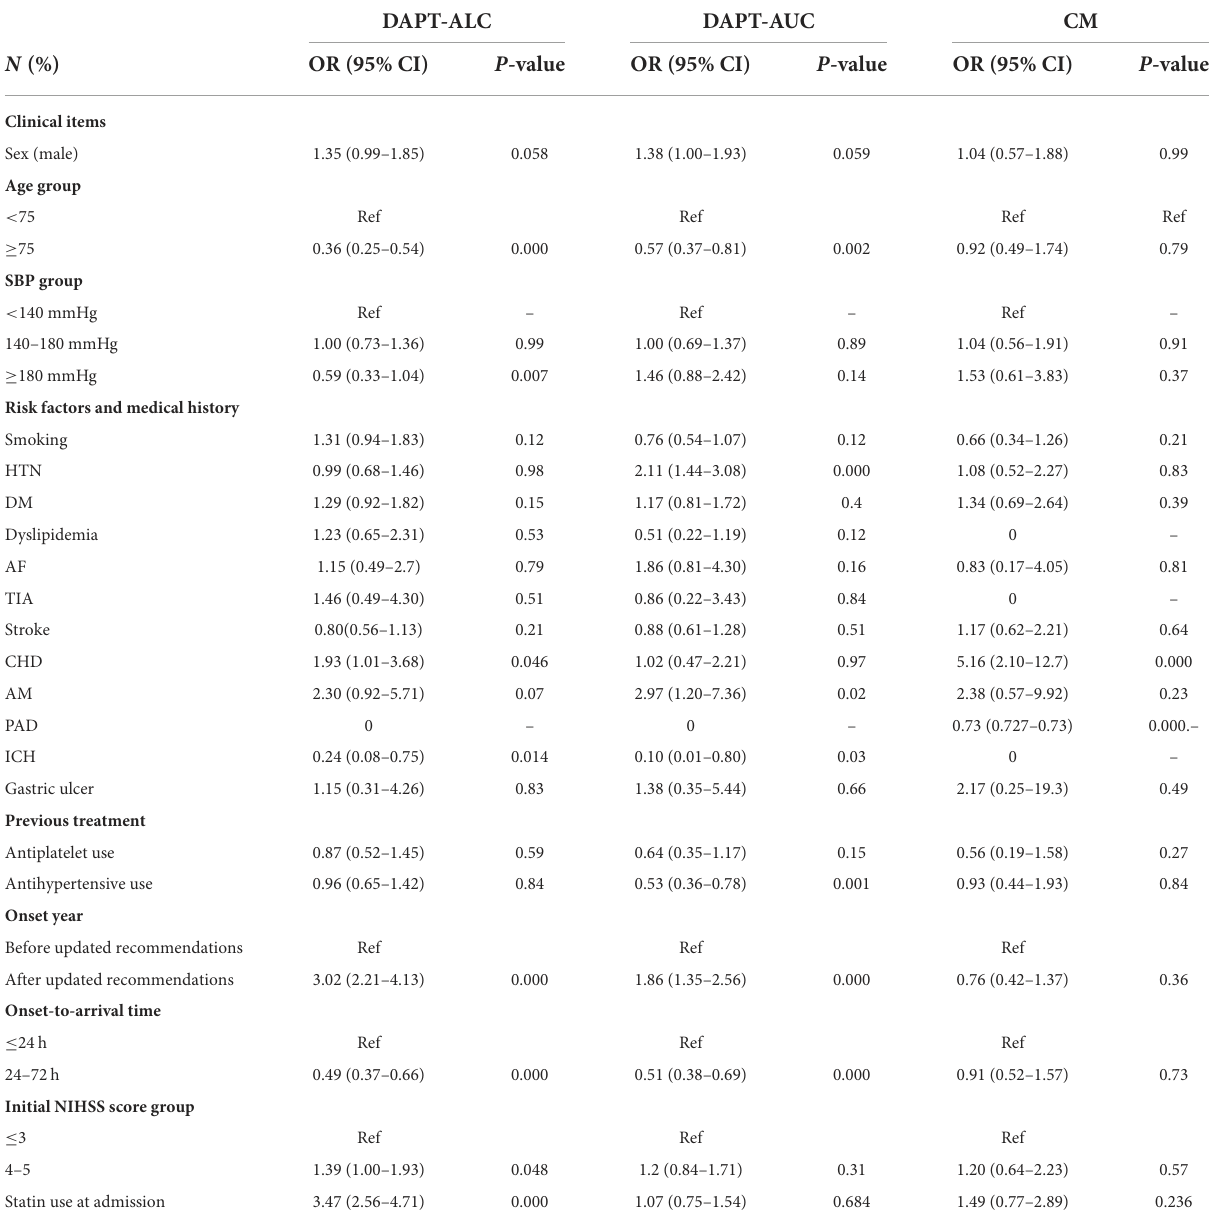
TABLE 2 Multinomial logistic regression analysis of different drug